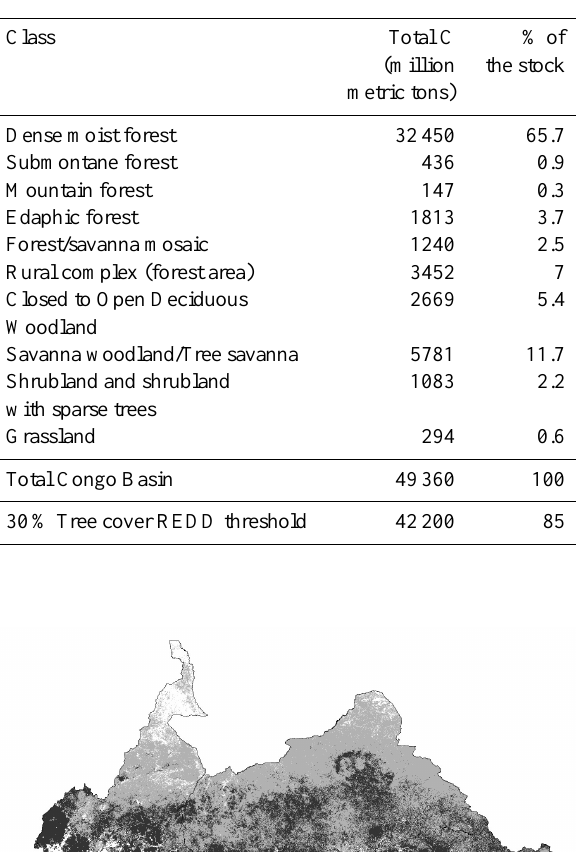
Table 8. Carbon stock in the Congo Basin calculated with the C stocks estimation of Nasi et al. (2009) and the Congo Basin vegeta- tion types map.